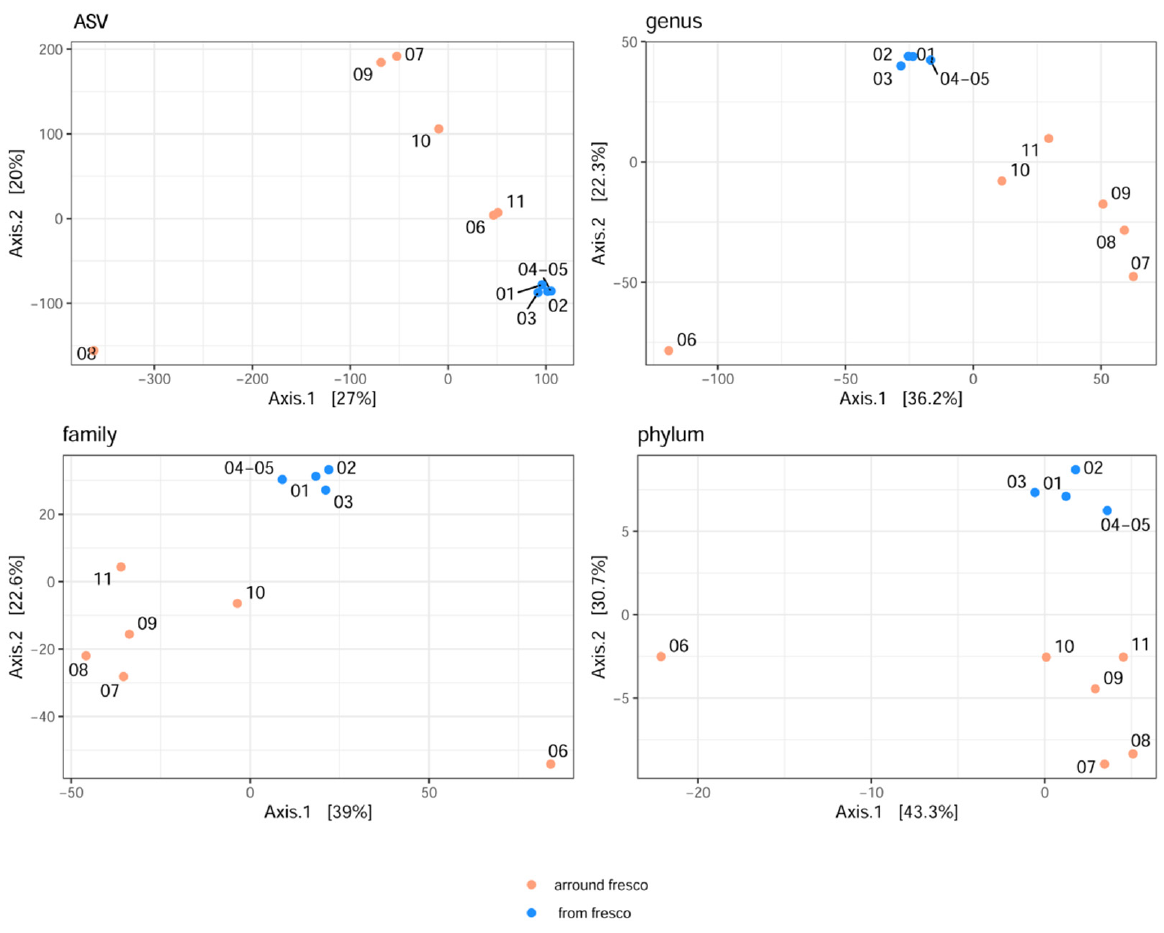
Figure 1. The MDS (PCoA) plot was created with Euclidean distances at the ASV, genus, family, and phylum taxa levels, showing the variability between samples. Values on the axes were scaled based on their own values. The results obtained indicate that in terms of microbiome diversity on all the taxonomic levels (explaining 27%, 36.2%, 39%, and 43.3% of variability, respectively), the samples from the fresco itself were similar to one another, as were the samples obtained from the side walls of the church. The greatest diversity at the level of the phylum, family, and genus, was noted for the sample obtained from the iconostasis (sample 06), while at ASV level, sample 08 was considerably distanced from the rest of them. However, at ASV level, samples 06 and 11 were closer in composition to the samples obtained from the